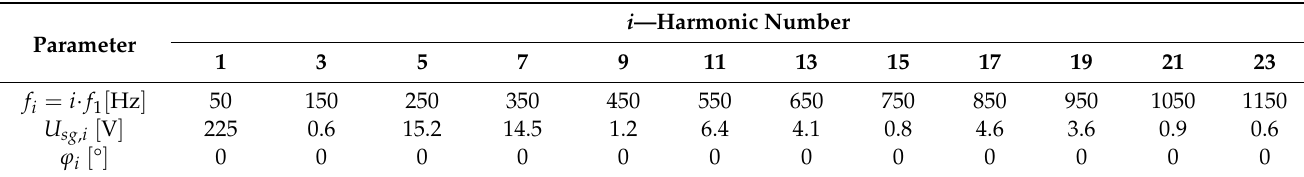
Table 3. Harmonic parameters of the signal from THDS U = 10.3%.